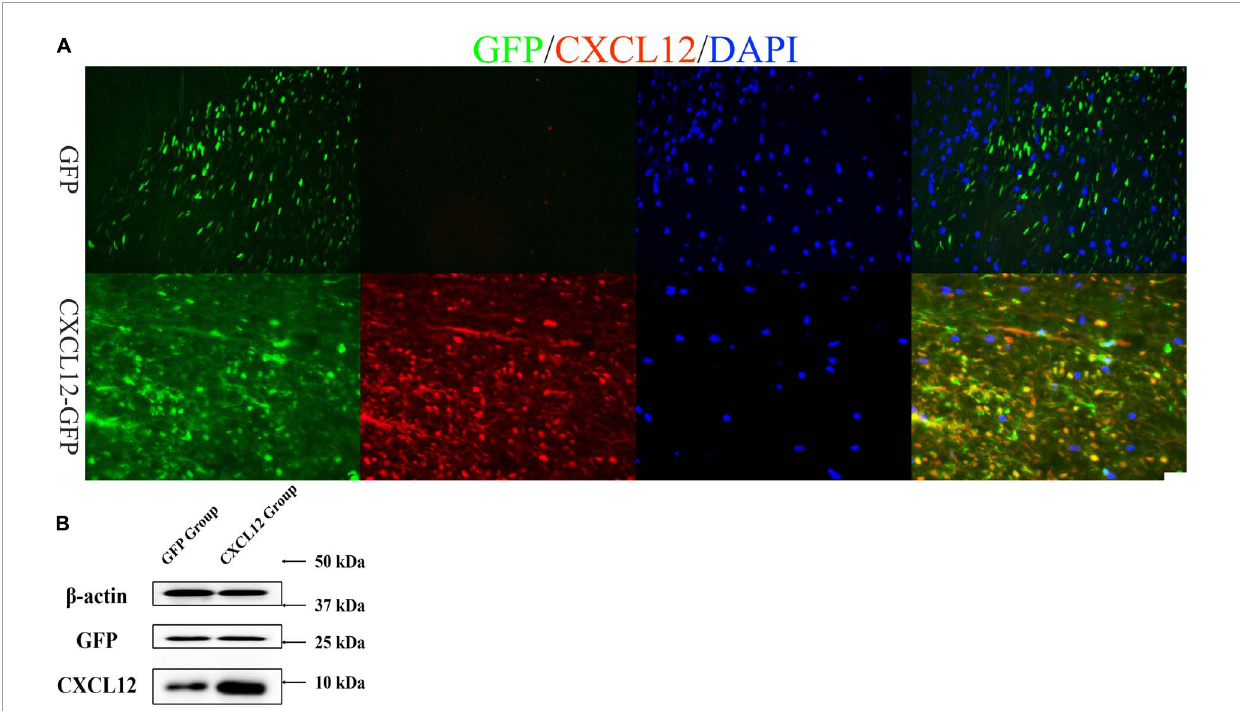
FIGURE1 CXCL12-GFP and eGFP were upregulated in the lumbar enlargement of the spinal cord. (A) Adeno-associated virus (AAV)-mediated upregulation of CXCL12 and eGFP in the lumbar enlargement was robust. On the 21st day after infection, immunofluorescence showed that the level of CXCL12 in the lumbar enlargement was much higher in the CXCL12-GFP group than in the eGFP group, and the CXCL12 and eGFP signals in the white matter were stronger than those in the gray matter of the spinal cord. The bar in the lower right represents 50 µ m. (B) Western blot (WB) results also show that the expression of CXCL12 in spinal cord of CXCL12 group, particularly in regions surrounding the cannula tip, was higher than the eGFP